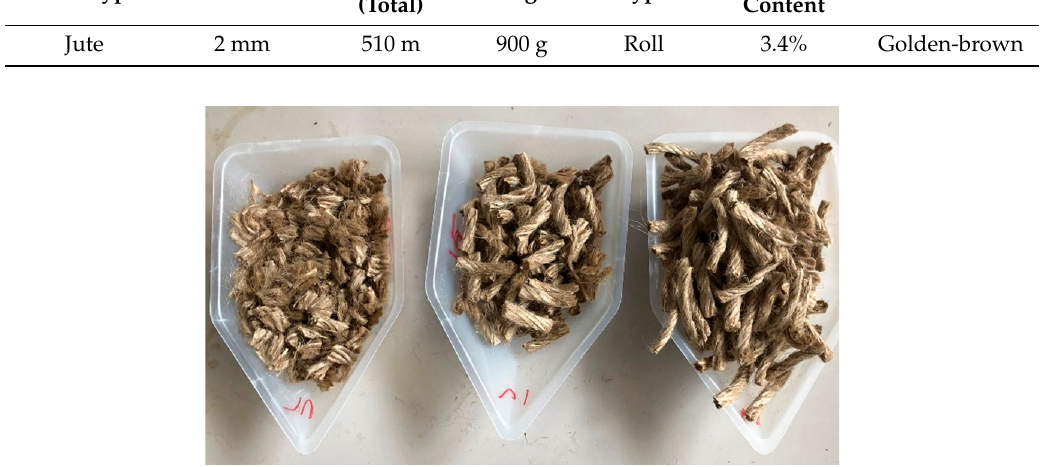
Figure 2. The physical appearance of the jute fibers used in this study, which were cut into different length.